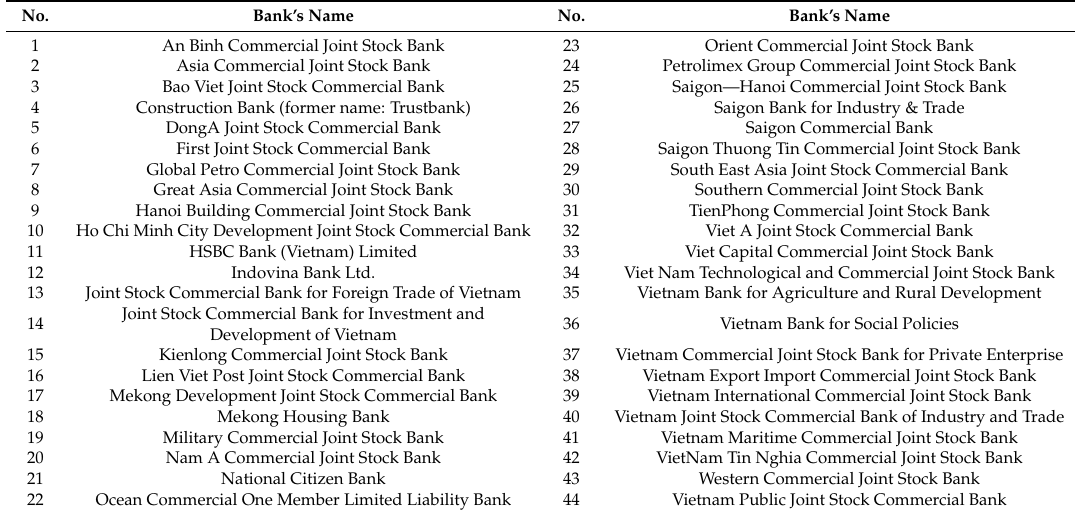
Table A1. Vietnamese banks included in the